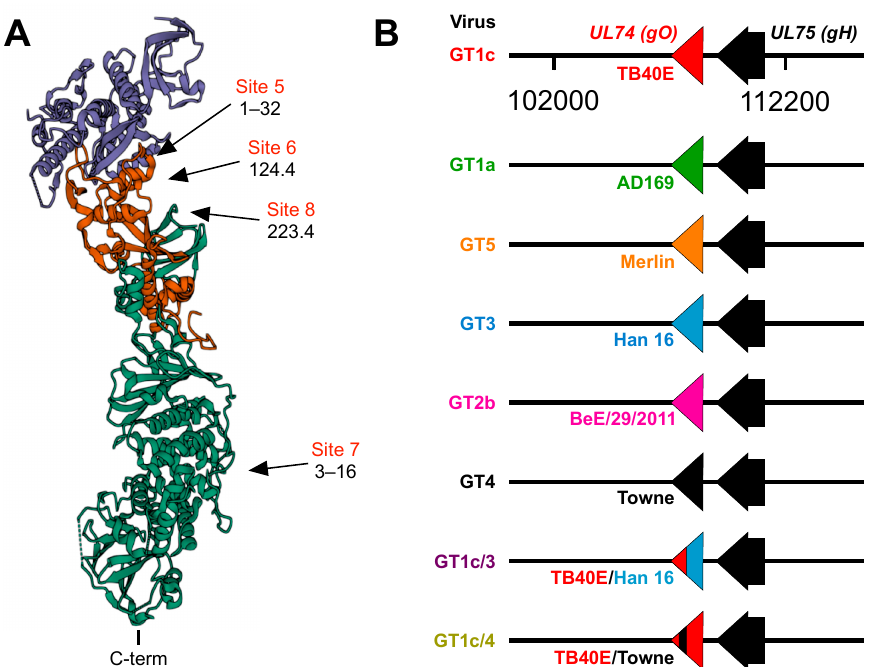
Figure 1. ( A ) Structure of the CMV trimer illustrating relevant immunogenic sites. The CMV trimer, as determined by cryoelectron microscopy [35], indicates the locations of gO (blue), gL (red), and gH (green) with the C-terminal transmembrane domain of gH oriented at the bottom. Approximate locations of immunogenic sites and the mAbs that target each site were inferred from mAb-gH/gL or mAb-trimer complexes characterized by negative staining electron microscopy [34] and cryoelec- tron microscopy [35]. ( B ) Schematic illustration of chimeric viruses. UL74 sequences encoding TB40/E gO in the parental virus GT1c were fully or partially replaced by UL74 sequences from the indicated CMV strains. All other sequences, including UL75 (encoding gH), are of the background strain TB40/E.